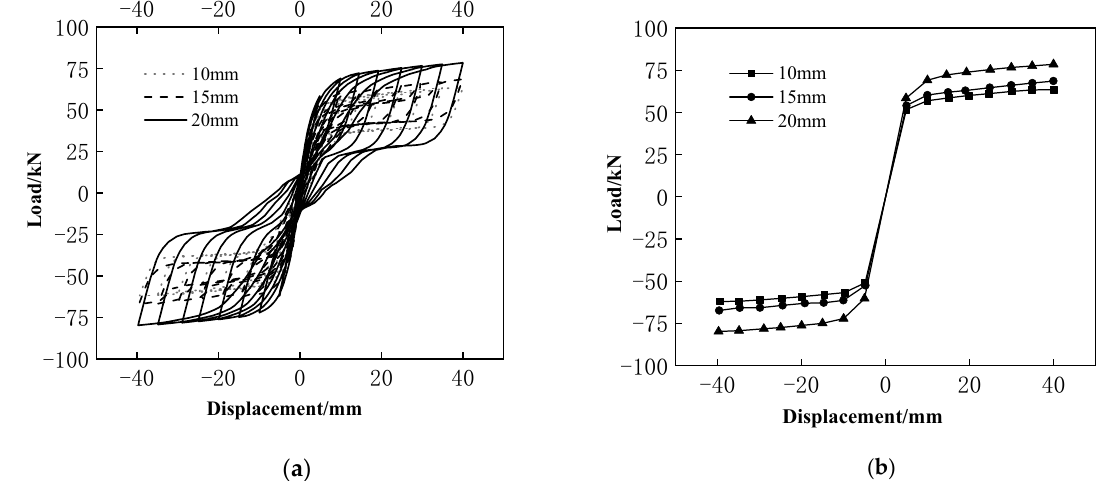
Figure 20. Hysteretic curve and skeleton curve under different section widths of energy dissipation ring. ( a ) Hysteretic curve. ( b ) Skeleton curve.